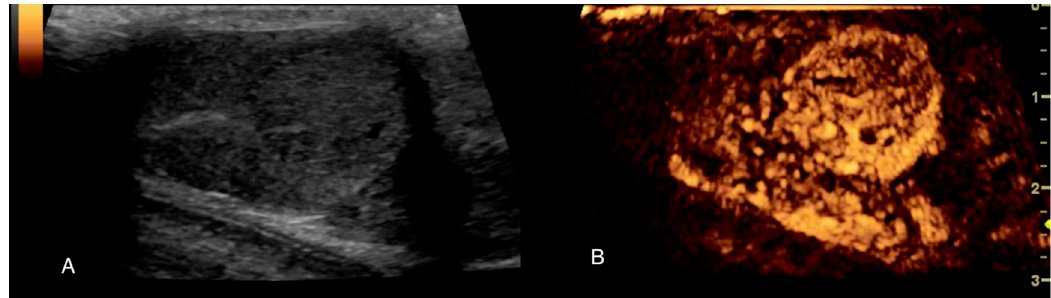
Figure 5. B-mode and Contrast ultrasound examination of the left testis of a 5-year-old mixed breed dog with seminoma. ( A ) B-mode image of the lesion; ( B ) early wash-in with tortuous feeding vessels, 25 s after contrast agent injection. CEUS enabled better and more detailed observation of the microcirculation.